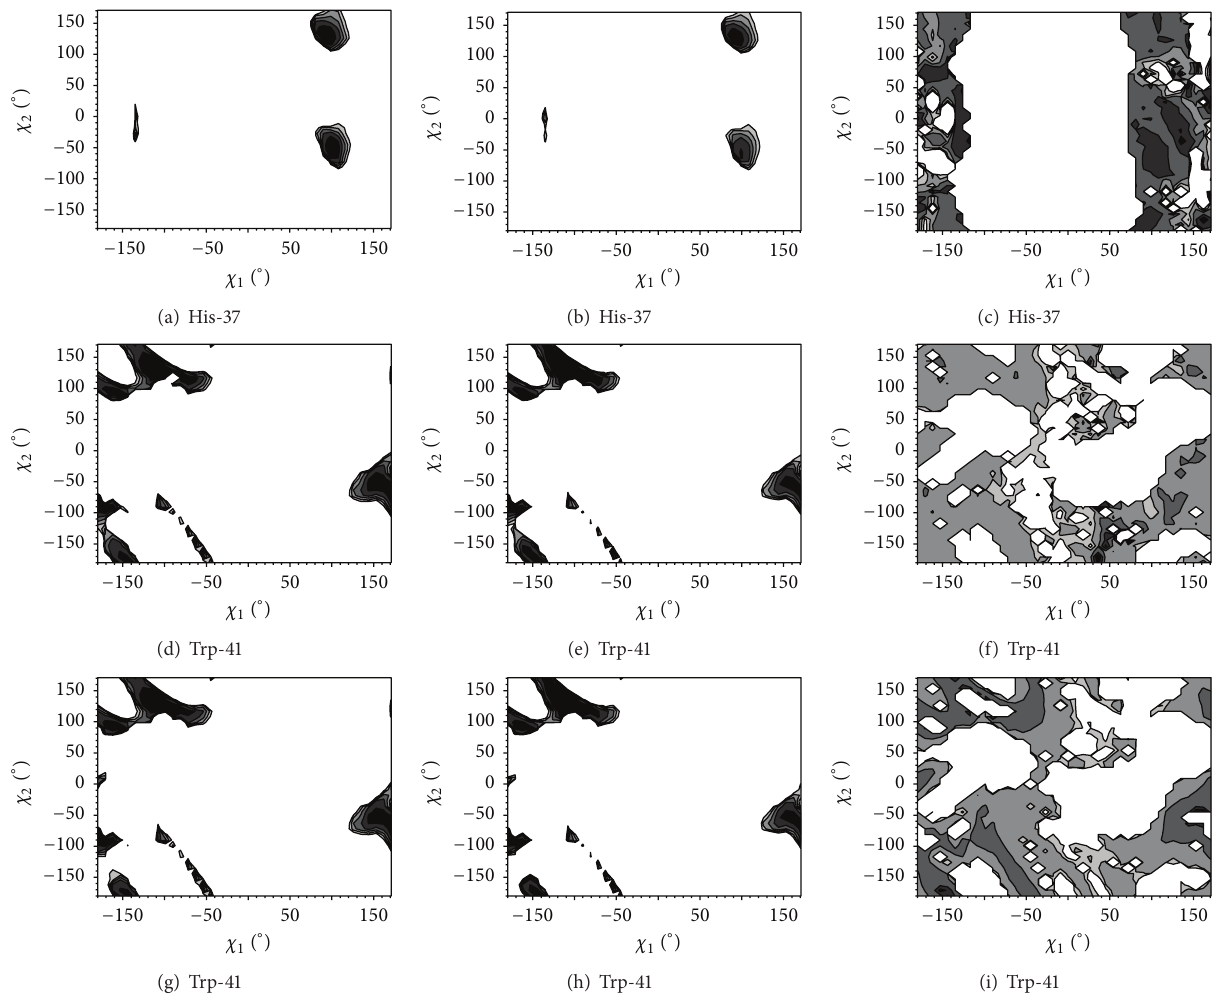
Figure 8: Torsion angle: energy maps of His-37 with fixed Trp-41 ( 𝜒 1 , 𝜒 2 ) = ( − 50 ∘ , +115 ∘ ) in (a), (b), and (c) and maps of Trp-41 with fixed His-37 ( 𝜒 1 , 𝜒 2 ) = (+95 ∘ , +130 ∘ ) in (d), (e), and (f) and (+100 ∘ , − 50 ∘ ) in (g), (h), and (i) at pH 5.0/open state. Panels (a), (d), and (g) represent total energies, (b), (e), and (h) Van der Waals energies, and (c), (f), and (i) electrostatic energies. All energy maps are shown within a 5 MJ/mol range from minimum (black) to higher energies (dark grey, grey, light grey, and